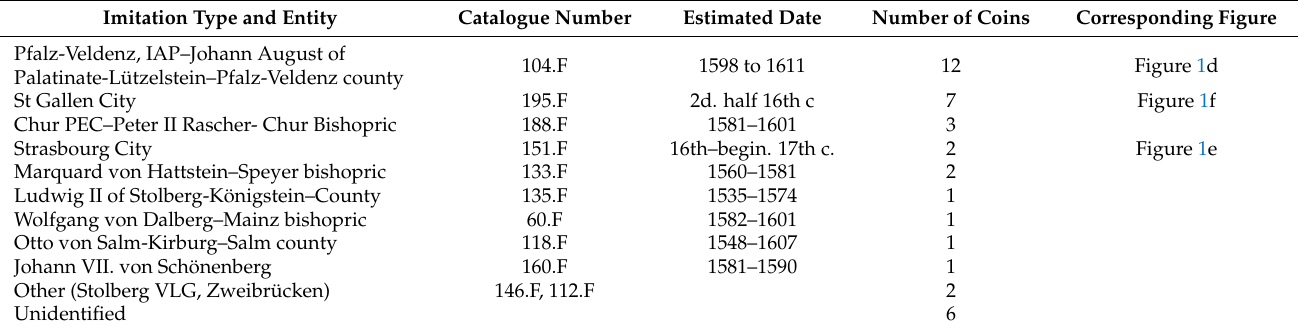
Table 1. Counterfeit coins identified in the hoard of Preuschdorf (Alsace, France) found in 2005. The design of the coin imitates that of the official coin (Pfennig) produced by entities having the right to mint coins, such as cities, bishoprics, counties, abbeys, and other small territories.